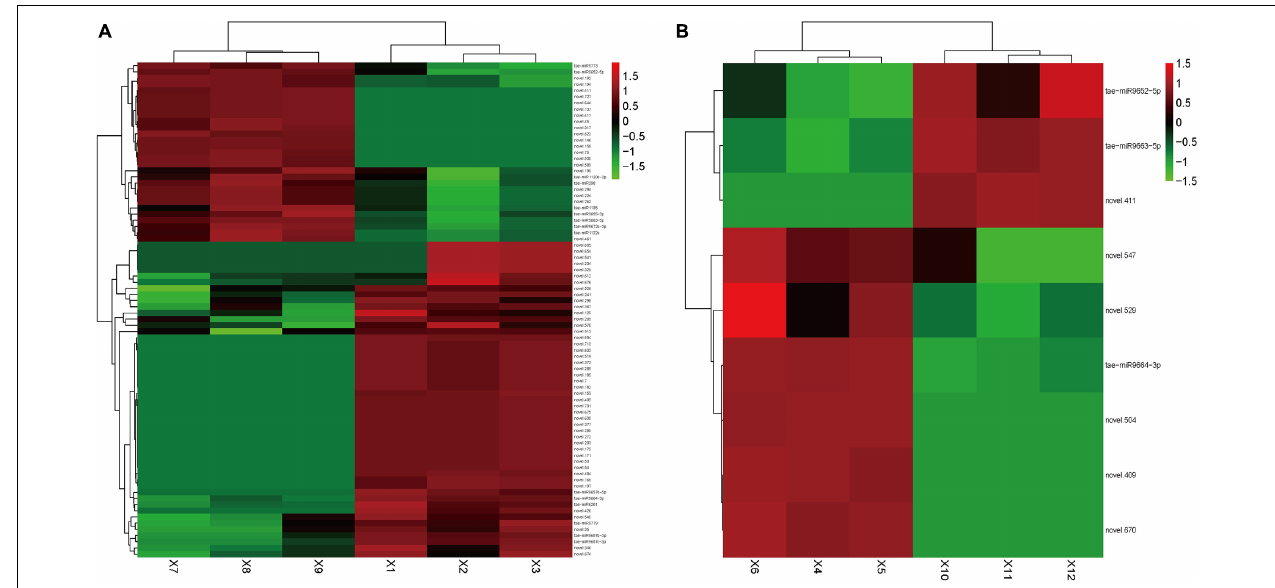
FIGURE 2 | Heatmap of differentially expressed small RNAs. Heatmap presenting the differentially expressed small RNAs in two tissues of the wheat, (A) roots and (B) leaves, in which green indicates down-regulation, and red indicates up-regulation.